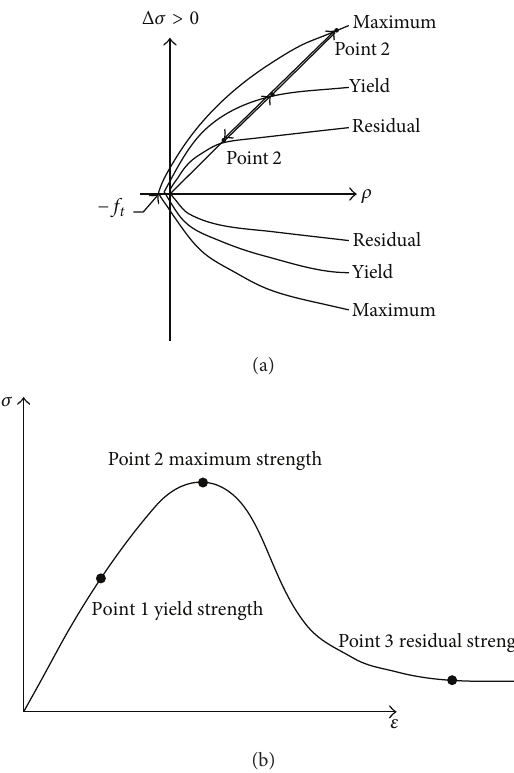
Figure3: Concretematerialmodel: (a)threestrengthfailuresurface and (b) stress-strain